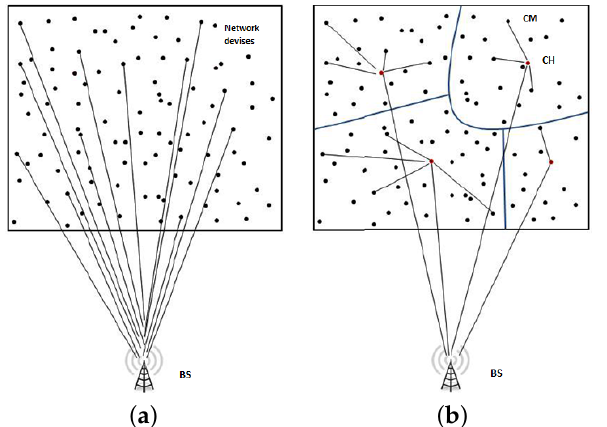
Figure 1. Connections toward the base station ( a ) using a flat architecture with individual connections, ( b ) using a structured and cluster-based